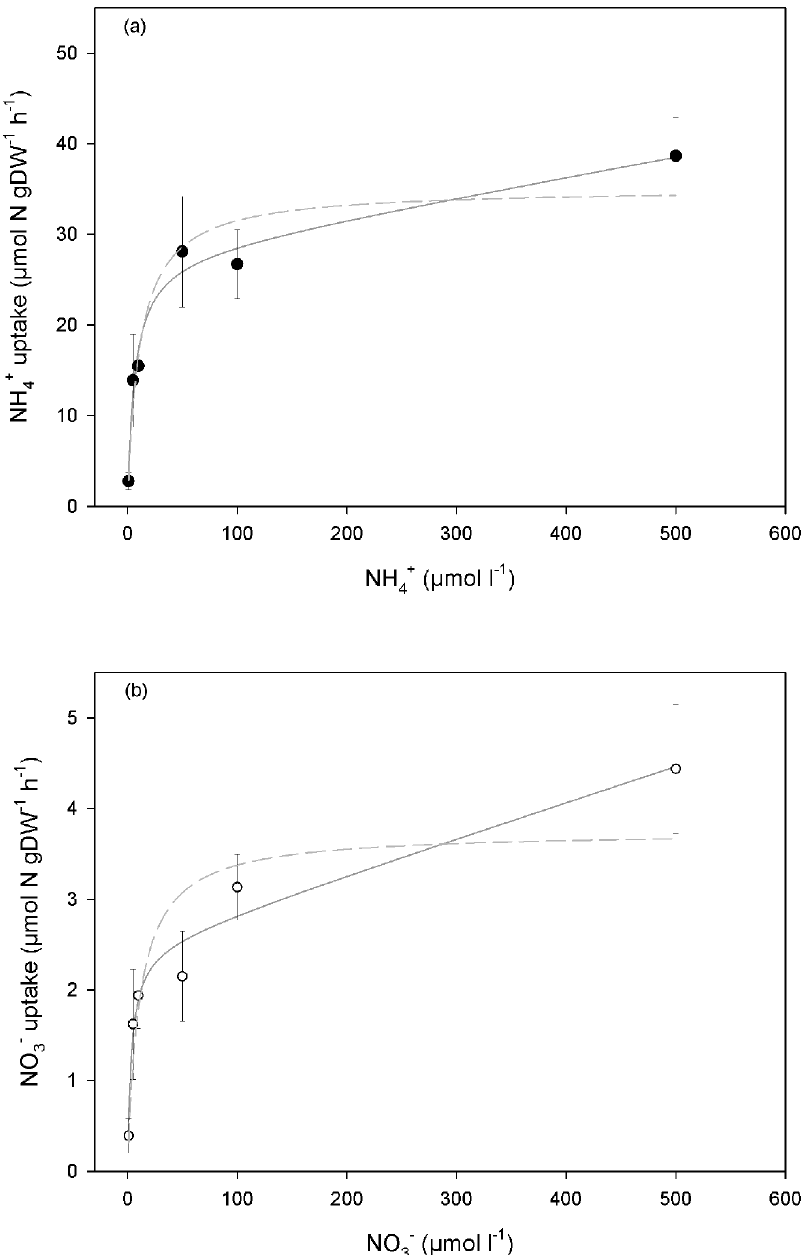
Figure 1. Dose response curves of (a) ammonium uptake rates (filled circles; m mol NH 4 + gDW 2 1 h 2 1 ) and (b) nitrate uptake rates (open circles; m mol NO 3 2 gDW 2 1 h 2 1 ) of Sphagnummagellanicum ( n =25) from the pristine site. The rates represent the average uptake rates after 0.5 hours including their standard error ( n =5). Note that y-axes differ by one order of magnitude. Saturation curves (Eq. 1) were fitted to rates: V max of ammonium (28 m mol NH 4 + gDW 2 1 h 2 1 ) was higher than V max of nitrate 2.5 m mol NO 3 2 gDW 2 1 h 2 1 ), whereas K m -values were similar (6.5 m M for ammonium and 3.5 m M for nitrate, respectively). The linear component k was higher for ammonium (0.022 l g 2 1 DW h 2 1 ) than for nitrate (0.004 l g 2 1 DW h 2 1 ). Dashed lines show the fit to uptake measurements using only two parameters (V max and K m ).